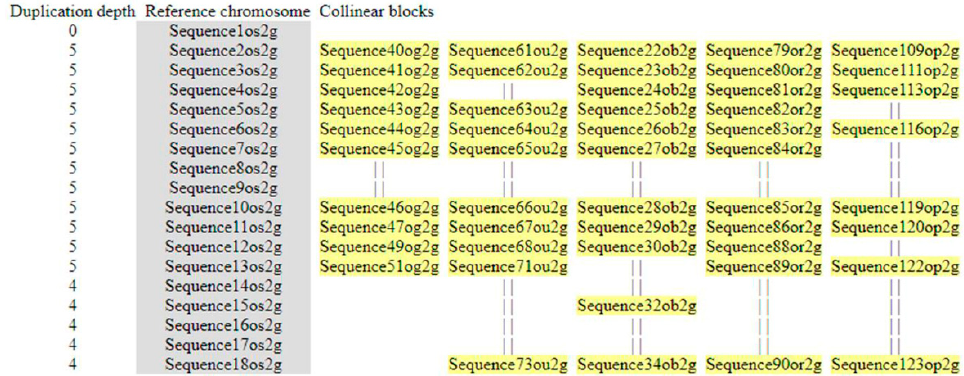
Figure 6. Diagrammatic representation of microsynteny analysis of 100 kb genomic segments flanking MIR397B across different poaceae members. Synteny block diagram for MIR397B with Oryza sativa as reference. The first column shows duplication depth at each gene locus; the second column shows the genes in reference chromosomes, and the following ones show aligned collinear blocks where only match genes are displayed. The alignment among non-anchor genes was discarded in the output and was simply denoted with “||” in the multi-alignment of gene orders.